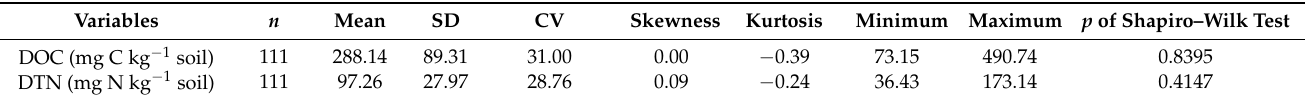
Table 2. Descriptive statistics of dissolved organic carbon (DOC) and dissolved total nitrogen (DTN). SD: standard deviation; CV: coefficient of